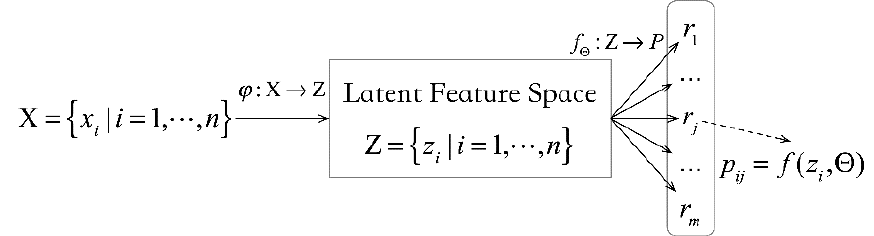
Figure 2. The procedure of network partitioning.